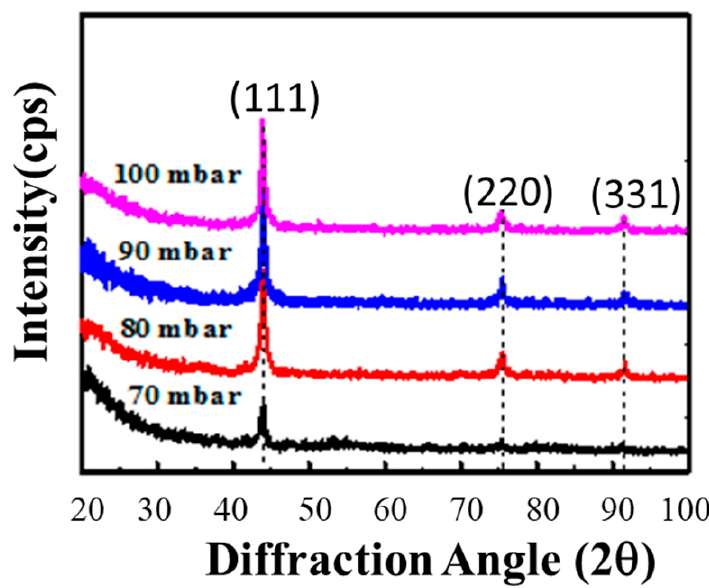
Figure 1. XRD diffractograms for N-UNCD films grown at different total pressures, keeping the microwave power constant at 4500 W.